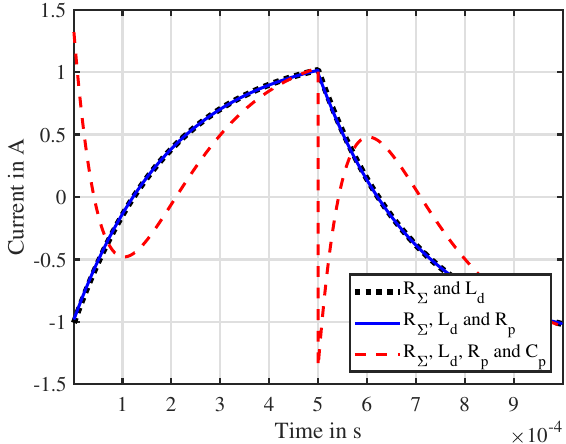
Figure 4. Simulated current inside the actuator in case of an underdamped system: R Σ = 10 Ω , L = 2 mH, C p = 5.01 µ F, R p = 1000 Ω , f pwm = 1 kHz, α =